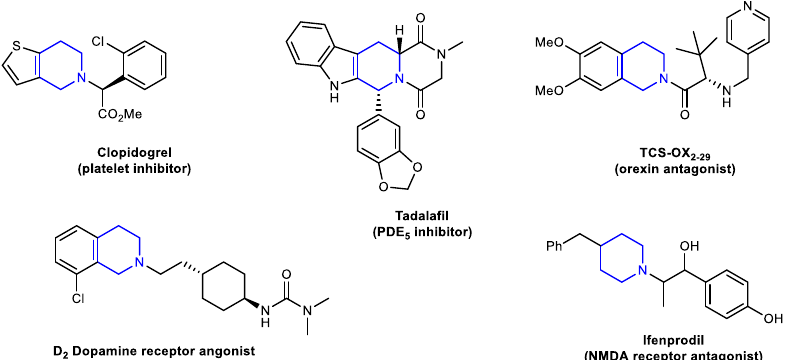
Fig. 2 Pharmaceutical relevant examples of piperidines. Piperidine is widely existed in natural products and serves as the most commonly used nitrogen heterocycle among U.S. FDA-approved pharmaceuticals.